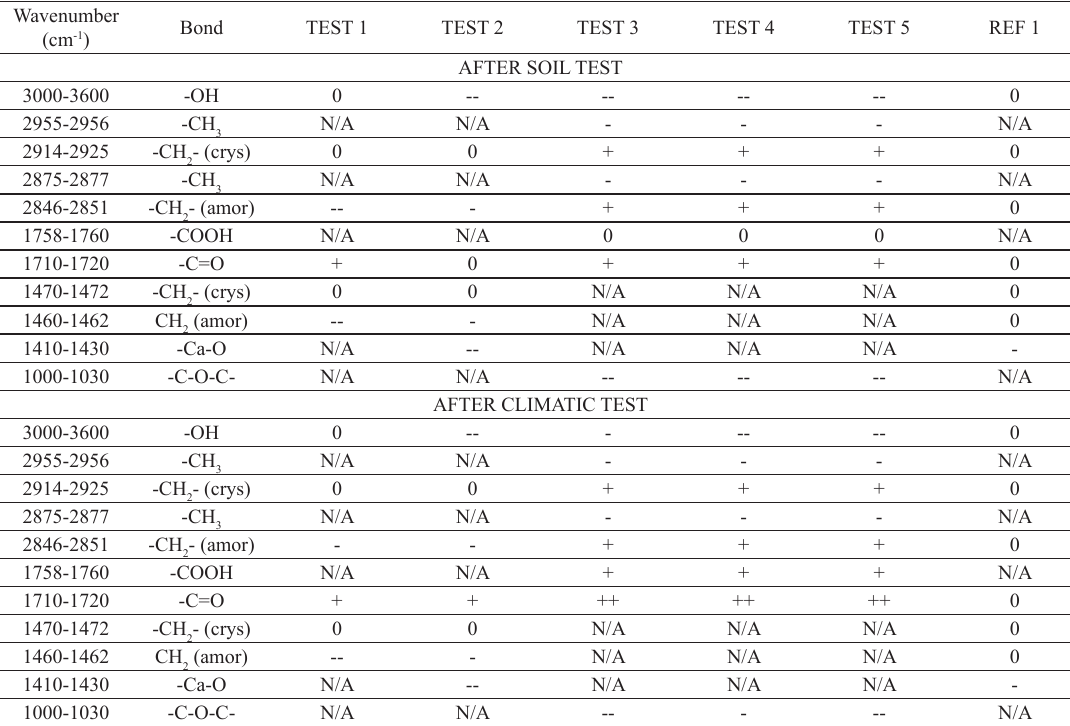
Table 5. The change in the absorption FTIR peaks intensity (functional groups) of the materials after the soil and climatic tests compared to the initial ones (by FTIR ATR). Wavenumber (cm -1 )